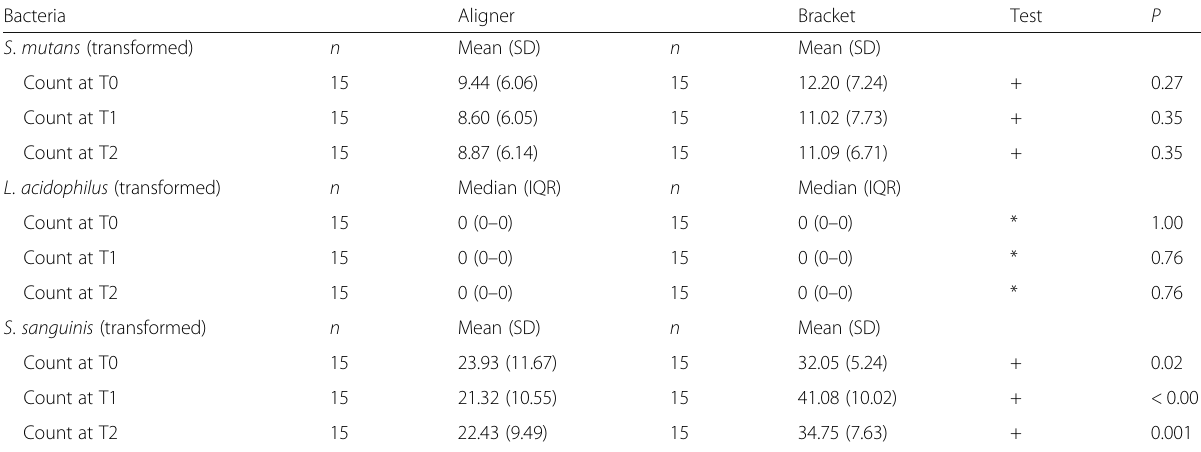
Table 5 Bacterial counts for each species (fifth root-transformed) at each time point and group with between-group testing with Mann-Whitney test (*) or t test for independent samples (+), according to normality of data Bacteria Aligner